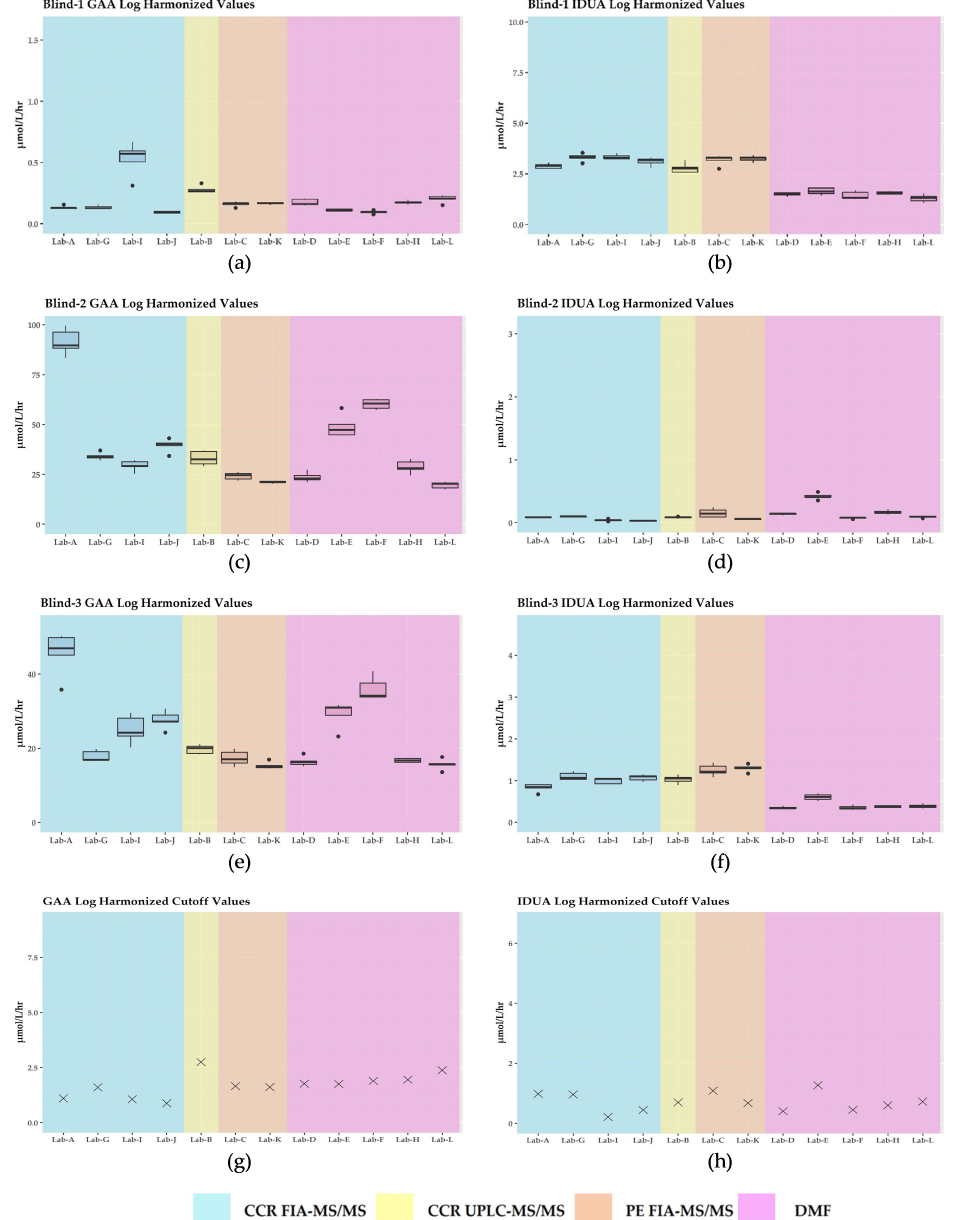
Figure 3. Plots for log harmonization of enzyme activities by laboratory: ( a ) deficient GAA specimen; ( b ) normal IDUA specimen; ( c ) normal GAA specimen; ( d ) deficient IDUA specimen; ( e ) normal GAA specimen; ( f ) low IDUA specimen; ( g ) GAA cutoff; ( h ) IDUA